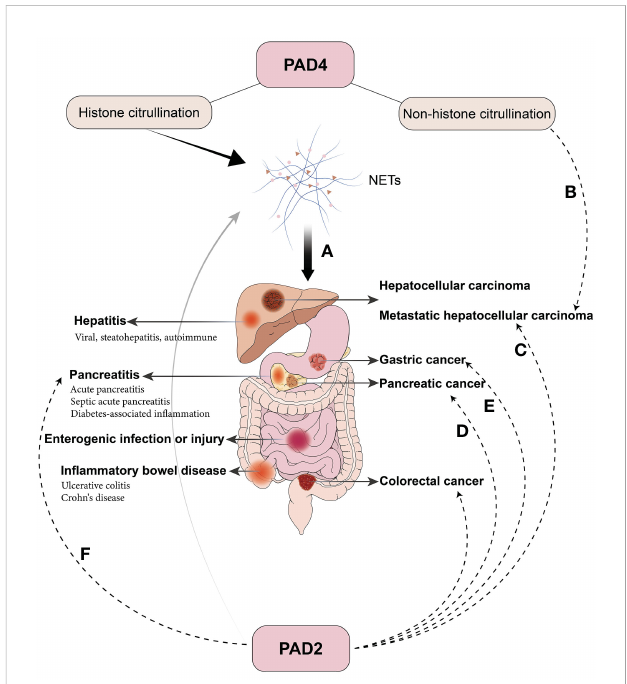
FIGURE 3 Pathological Roles of PAD2/4 in digestive diseases. (A) PAD4-mediated histone citrullination results in NETs and contributes to various in fl ammatory and oncological diseases in the digestive system. (B) Citrullination of extracellular non-histone proteins mediated by PAD4 promotes liver metastasis in colorectal cancer. (C) PAD2 promotes colorectal cancer cell invasion and liver metastasis by METs and citrullination of b -catenin. (D) PAD2 is highly expressed in several pancreatic cancer cells, and selective inhibitors suppress the invasion and regulate the secretion of anti- or pro-oncogenic miRNA in extracellular vesicles. (E) PAD2 inhibition hinders cell growth and migration in gastric cancer. (F) PAD2 is elevated in septic AP and correlates with CitH3 and patient